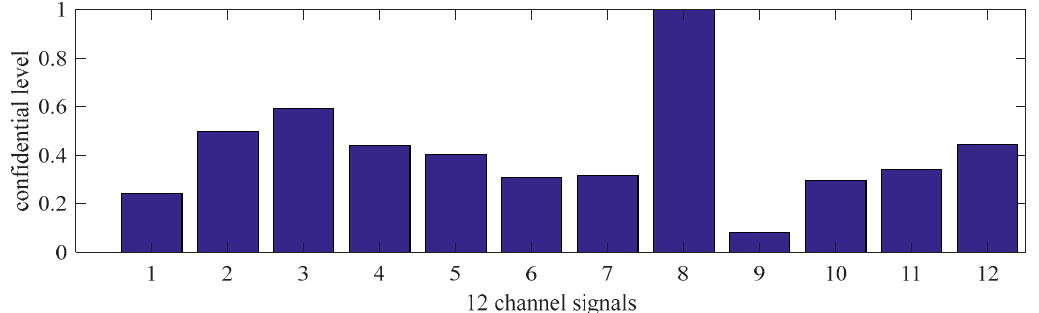
Figure 12. The confidence levels of 12 channel signals based on Algorithm 2. Reasoning Process for Multi-period single sensor reliability fusion algorithm.